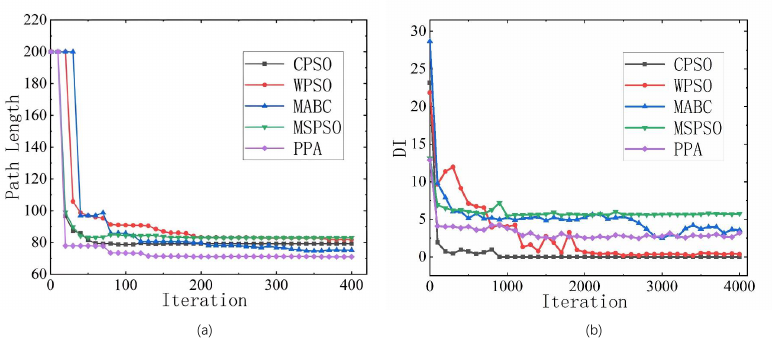
Figure 7. Convergence comparison on 50 × 50 maps where ( a ) is the path length change curve during iteration and ( b ) shows the curves of the diversity of individuals ( DI ) within 4000 iterations.